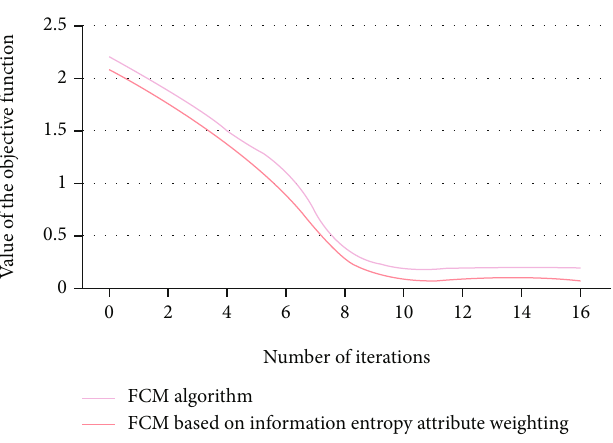
Figure 1: Comparison of objective